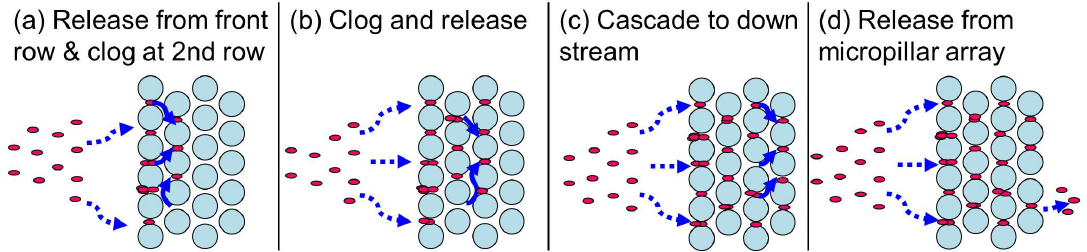
Figure 3. Schematic illustration of the repetitive clog-and-release process. ( a ) Once the clogged cells are released from the gaps in the front row of the micropillar array, they move along the flow and become clogged at gaps in the second row. ( b ) The cells are again gradually pushed through the gaps and flow toward the third row. ( c ) This clog-and-release process cascades downstream. ( d ) The cells are released from the gap at the last row. Blue arrows indicate the direction of cell